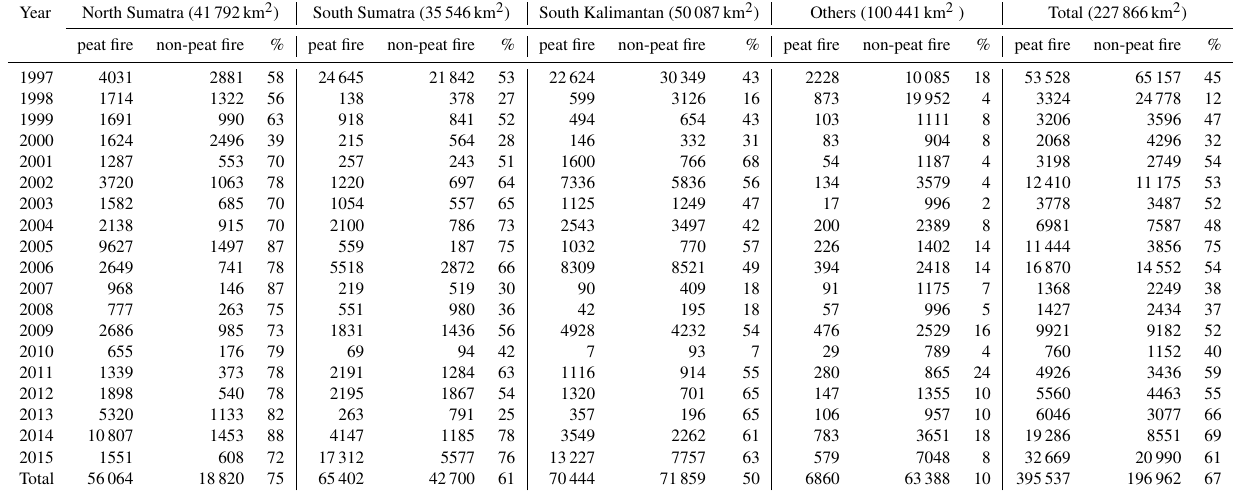
Table 1. Number of active fire detections for the different regions including the number of fires detected in peatlands, with percentage of peatland. For each region the total surface of peatland is shown on top of each column. Year